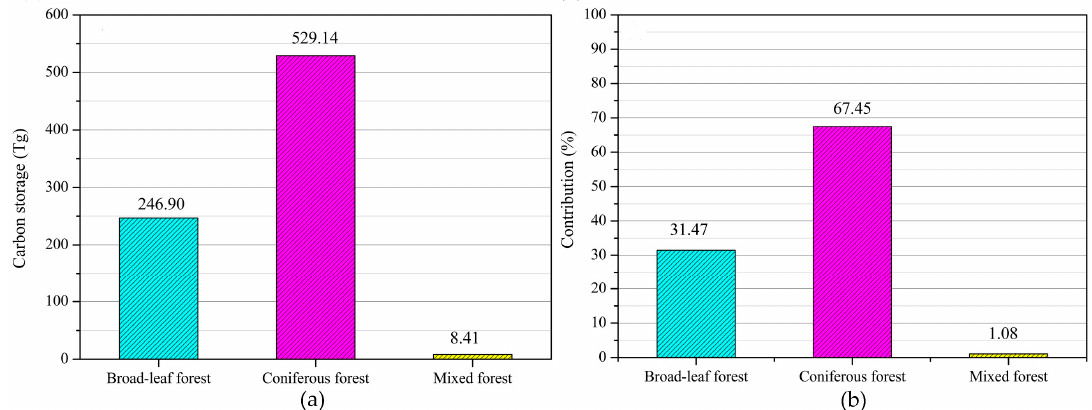
Figure 5. Carbon storage of broadleaf, coniferous and mixed forests ( a ) and the contribution of broadleaf, coniferous, and mixed forests to the total carbon storage ( b